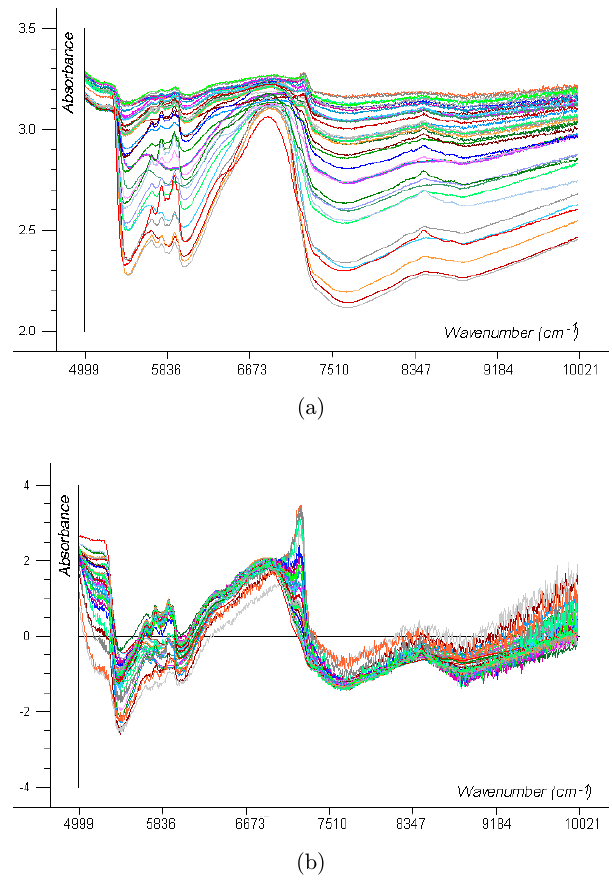
Fig. 2. NIR spectra obtained every minute from in-situ monitoring during the alcohol precipitation: (a) raw NIR spectra and (b) preprocessed spectra with